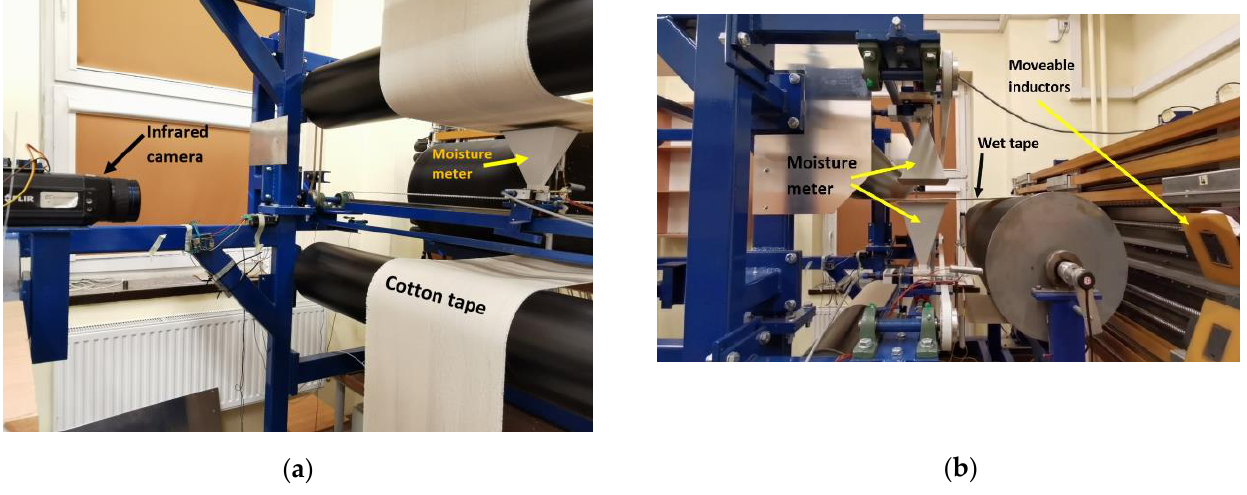
Figure 2. General view of the actual drying stand ( a ). Side view of the dryness meter and moving inductors heating the cylinder ( b ).